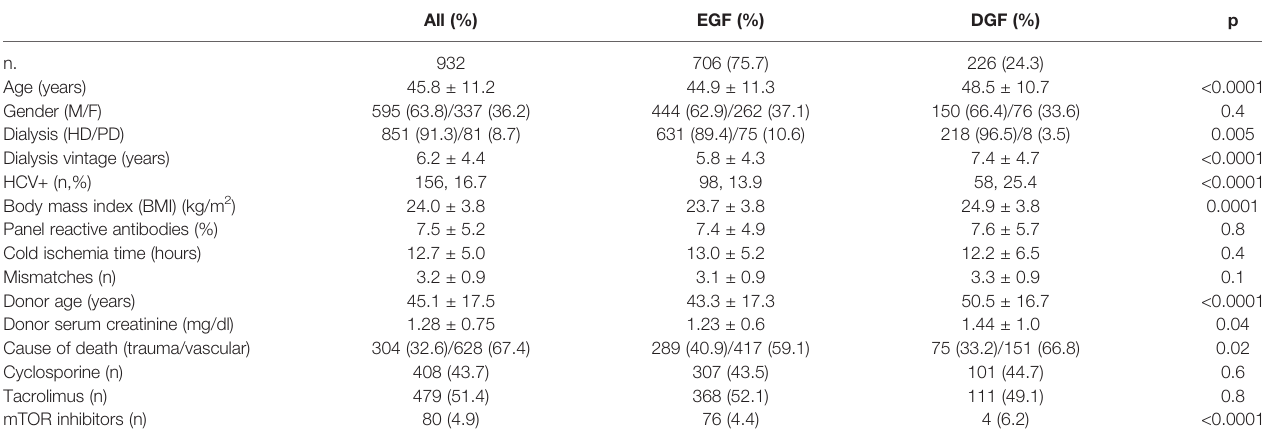
TABLE 1 | The main demographic and clinical data of the patients included in the study.